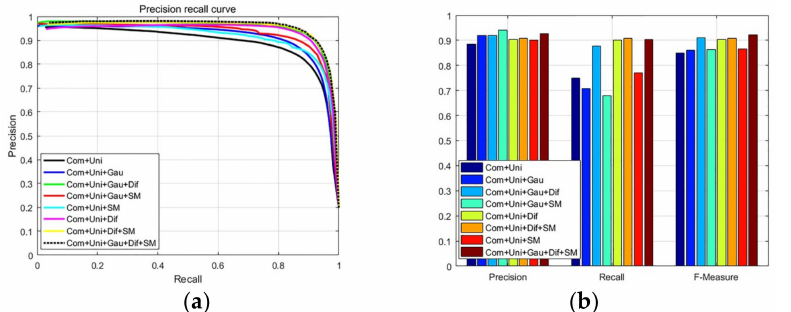
Figure 11. Valuation of influence of different components. ( a ) Precision-recall curves. ( b ) Precision, recall, and F-measure at adaptive threshold. Com: compactness-based saliency calculation; Uni: uniqueness-based saliency calculation; Gau: saliency-biased Gaussian model; Dif: diffusion process with nonlocal connections; SM: single-layer updating and multi-layer integration